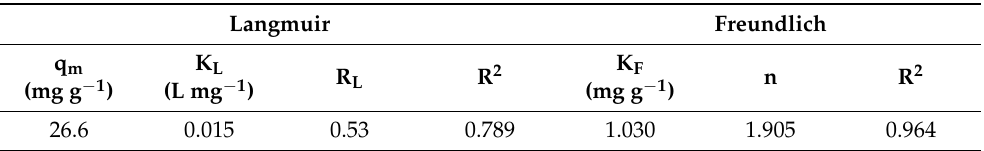
Table 2. Characteristic coefficients of Langmuir, and Freundlich isotherms (C 0 = 60 mg L − 1 , 0.7 g L − 1 adsorbent, 25 ◦ C, 24 h).